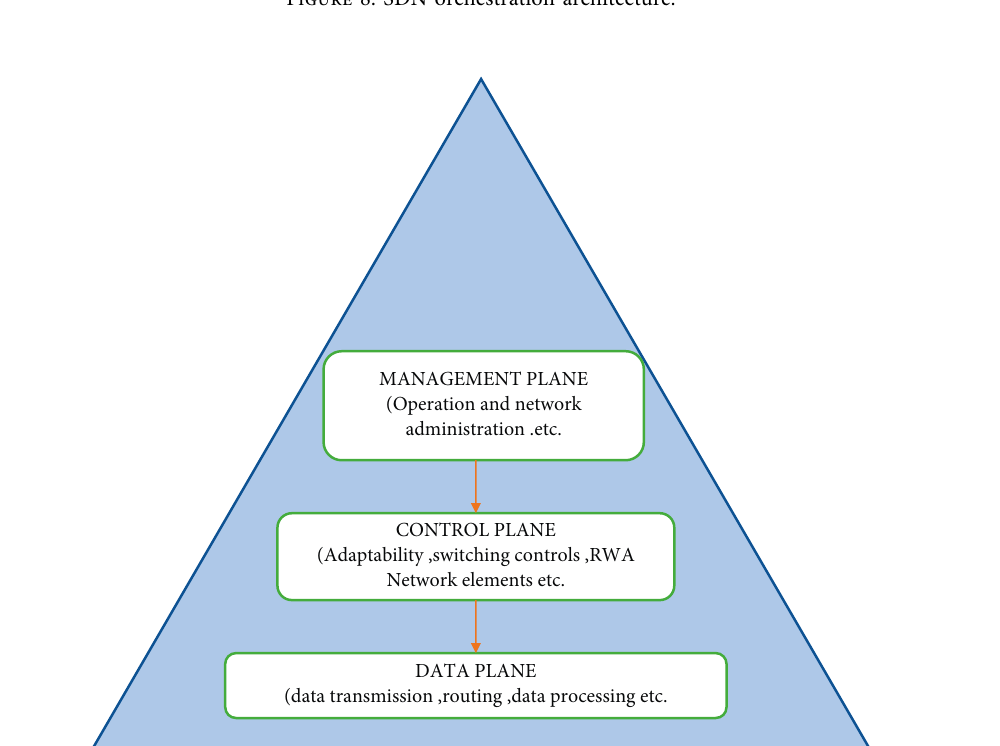
Figure 9: SDN-based optical network hierarchy.